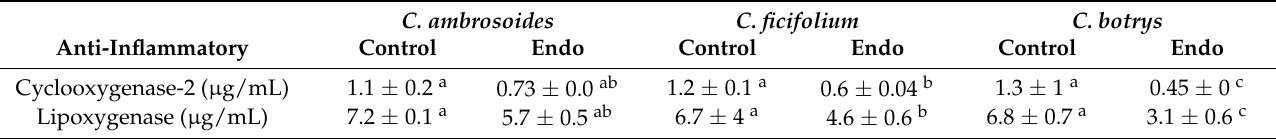
Table 7. Anti-inflammatory activity of control and endophytic bacterial-treated Chenopodium ambrosoides, Chenopodium ficifolium, and Chenopodium botrys sprouts. Data are represented by the means of at least 3 replicates ± standard deviations. Different small letter superscripts (a, b, and c) within a row indicate significant differences between control and endophytic bacterial